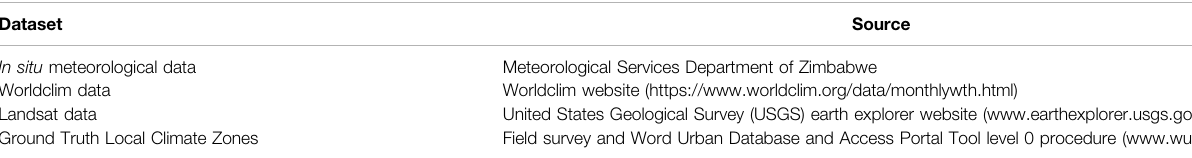
TABLE 1 | Sources of data used in this study. Dataset